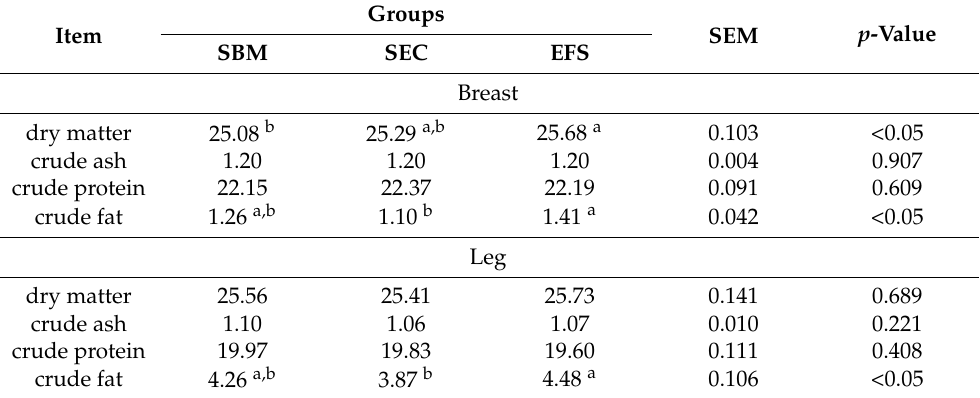
Table 5. Basal nutrient content (g · 100 g –1 ) of muscles.